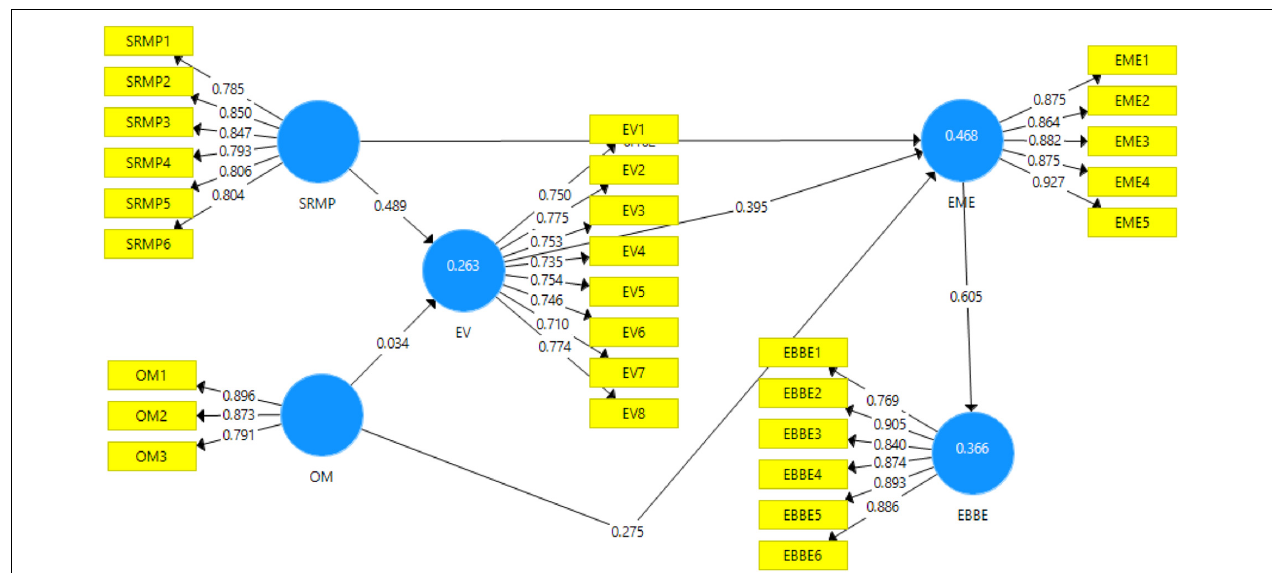
FIGURE 2 | Output of measurement model. SRMP, socially responsible management; OM, organizational morality; EV, employee vitality; EME, employees’ morale engagement; EBBE, employee-based brand